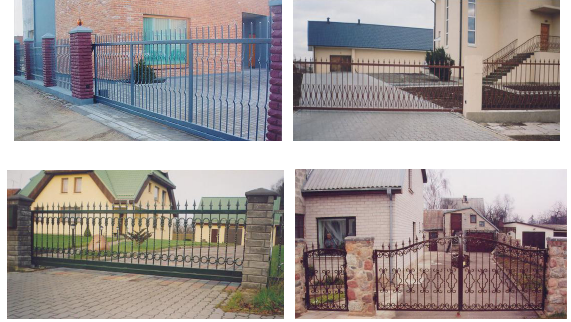
Fig 1. The gates erected to restrict transport and pedestrian